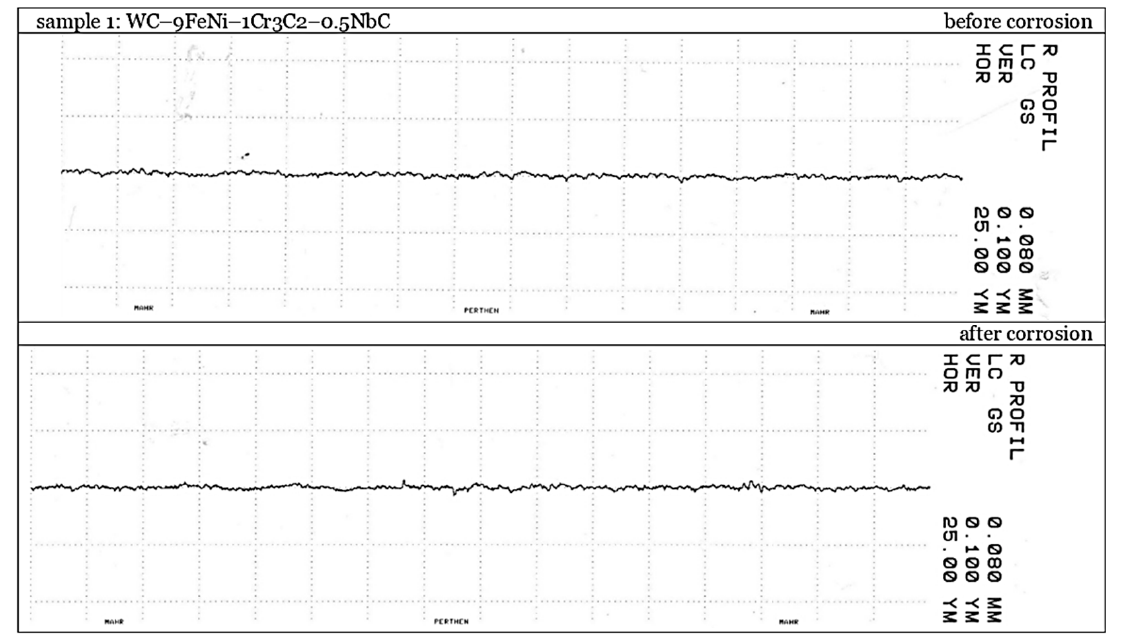
Figure 13. Characteristic profiles before and after electrochemical corrosion testing of sample 1: WC–9FeNi–1Cr 3 C 2 –0.5NbC.